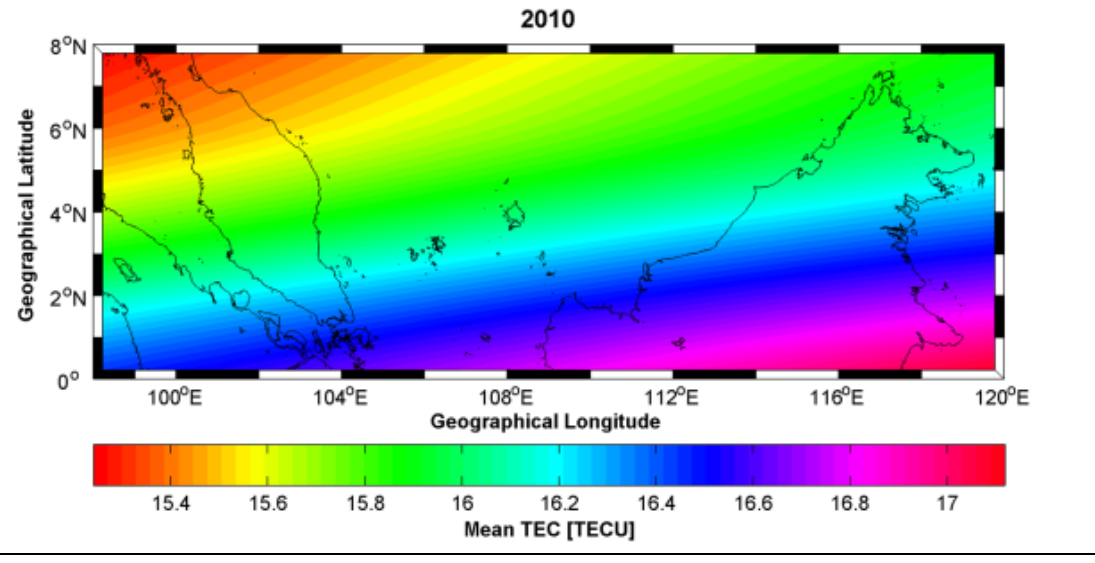
Figure 2. Spatial variation of an average TEC during year 2010 over Malaysia (Musa et al.,